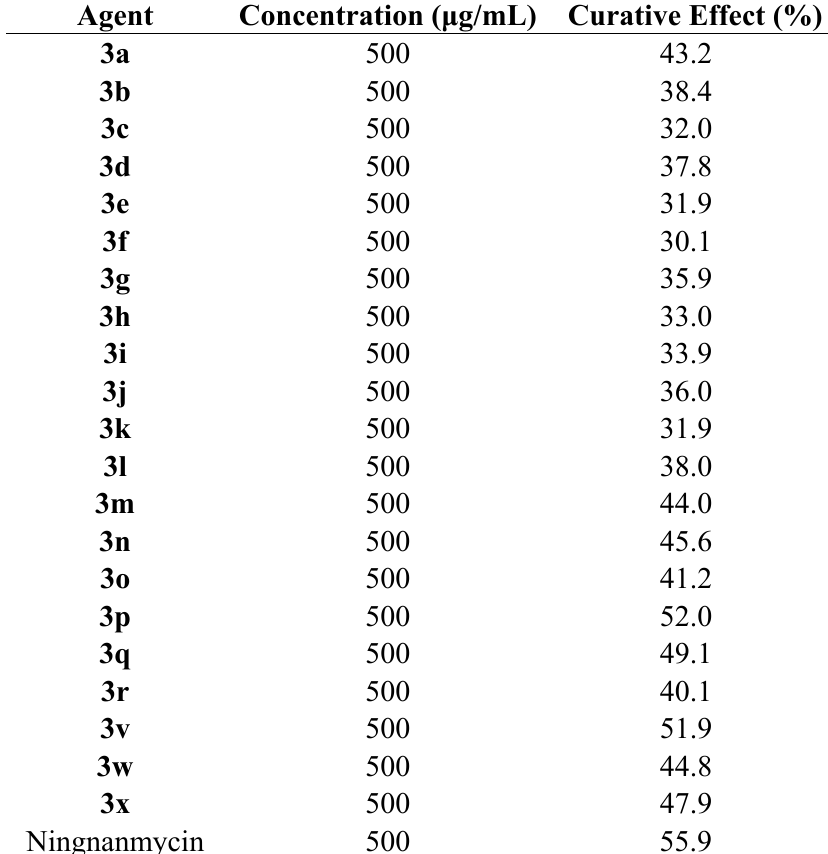
Table 3. The curative effect of the compounds 3a – x against TMV in vivo